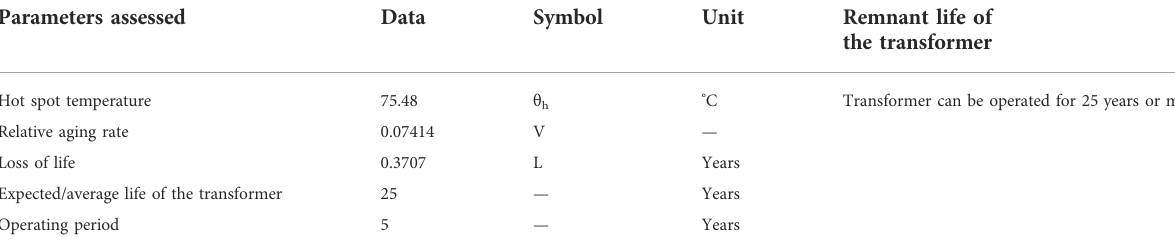
TABLE 5 Estimating the remnant life of the transformer based on the relative aging rate.